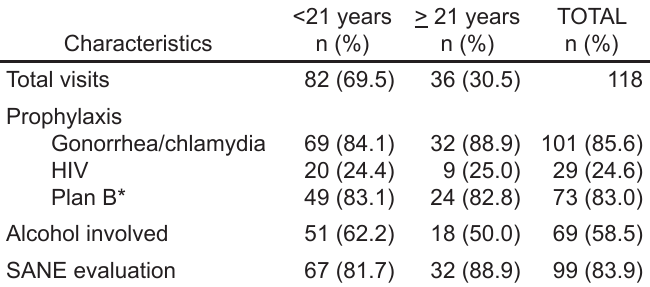
Table. Clinical characteristics of sexual assault cases by age group among emerging